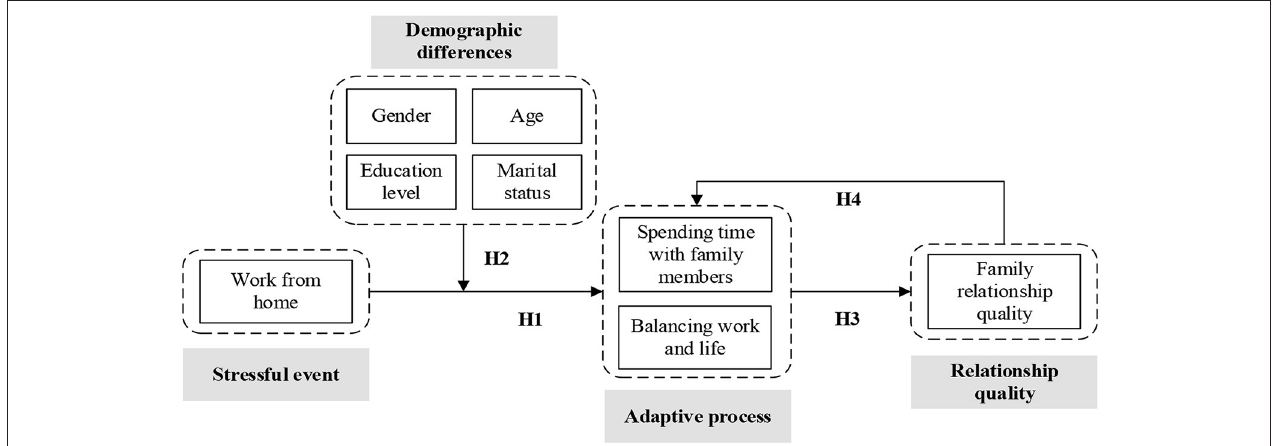
FIGURE 1 | Proposed conceptual